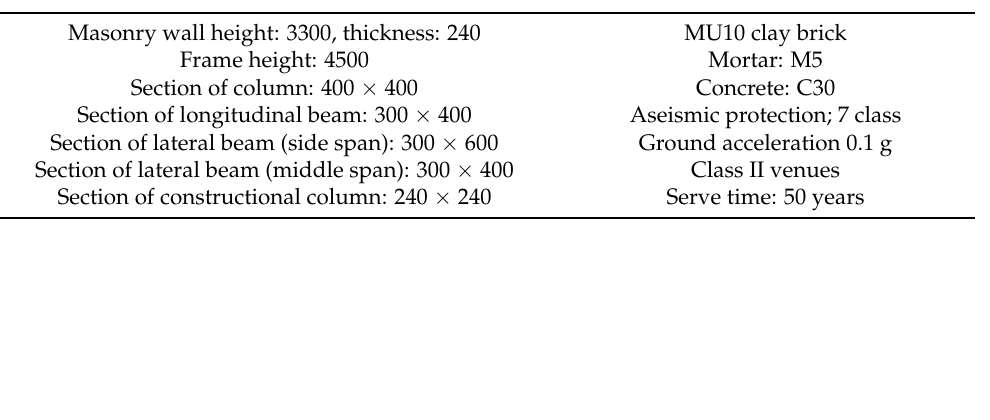
Table 1. The information of the tested bottom frame structure